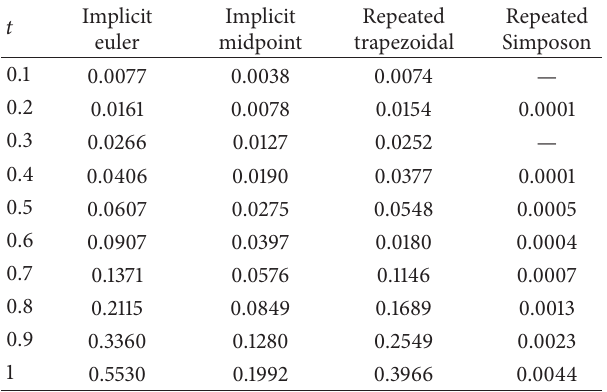
Table 1: Absolute errors in the solution of (48) when ℎ = 0.01 .